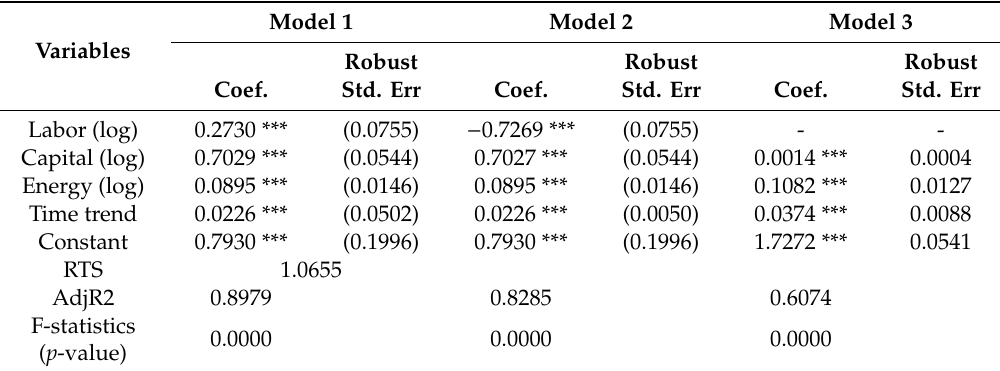
Table 4. Pooled OLS estimation results for the three